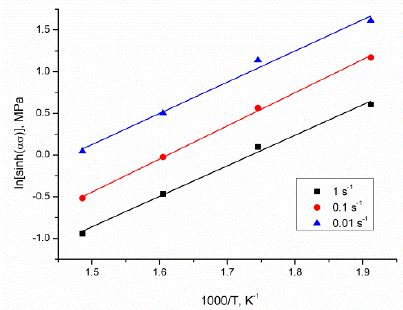
Figure 6. The relationship between ln( 𝜀(cid:4662) ) and ln[𝑠𝑖𝑛ℎ(𝛼𝜎)] . Figure 7. The relationship between ln [ sinh ( ασ )] and temperature (1000 / T, K − 1 ). Figure 7. The relationship between ln[𝑠𝑖𝑛ℎ(𝛼𝜎)] and temperature (1000/T, K − 1 ).